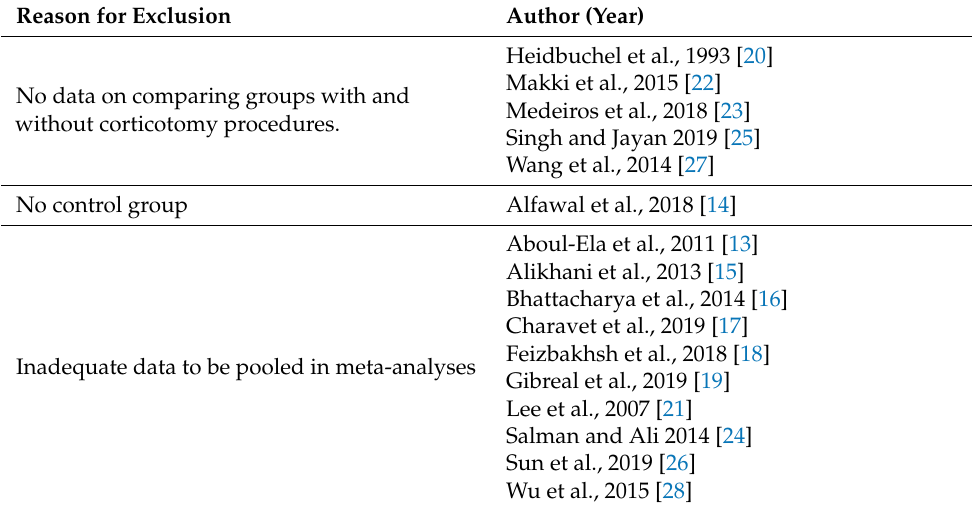
Table 1. Summary of the excluded